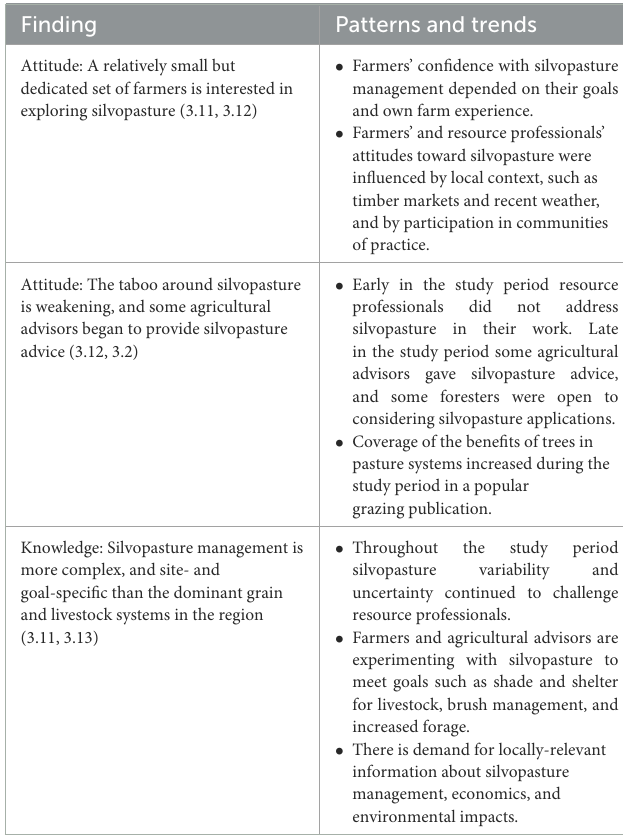
TABLE 2 Overview of silvopasture knowledge and attitudes in Wisconsin USA and surrounding states from 2014 to 2019 interviews with